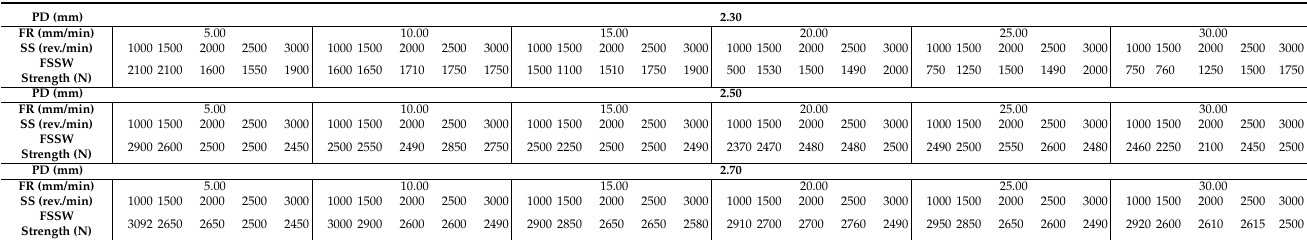
Table 4. Strength of FSSW with FR, SS, and PD.